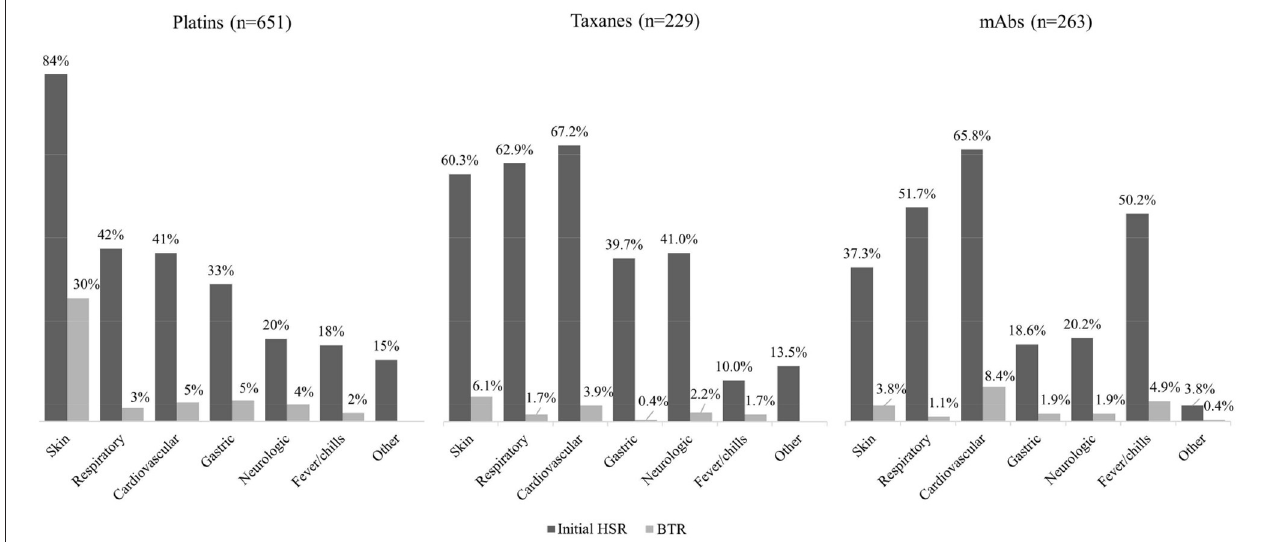
FIGURE 3 | Clinical symptoms of initial HSRs and BTRs in 1,143 procedures of desensitization. mAbs, monoclonal antibodies; HSR, hypersensitivity reaction; BTR, breakthrough reaction.